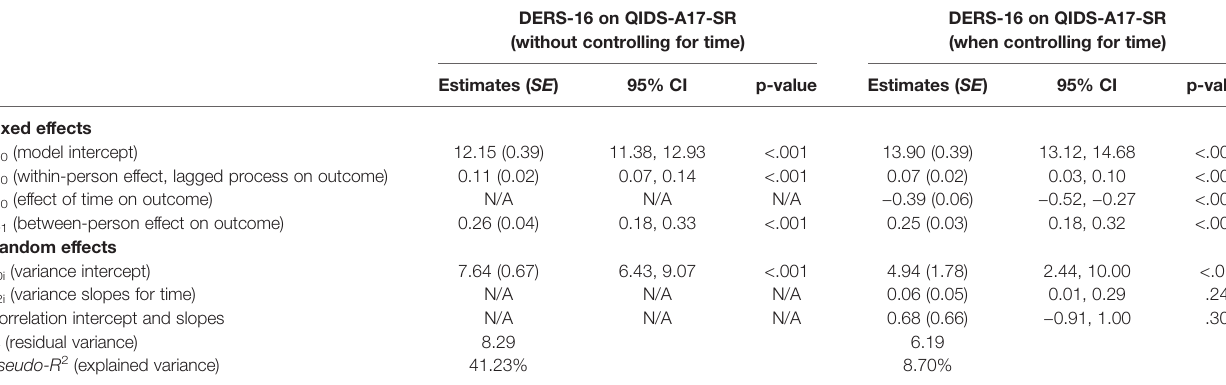
TABLE 4 | Within-person effects of DERS-16 on QIDS-A17-SR: parameter estimates, standard errors, 95% con fi dence intervals, and p values (n = 67).